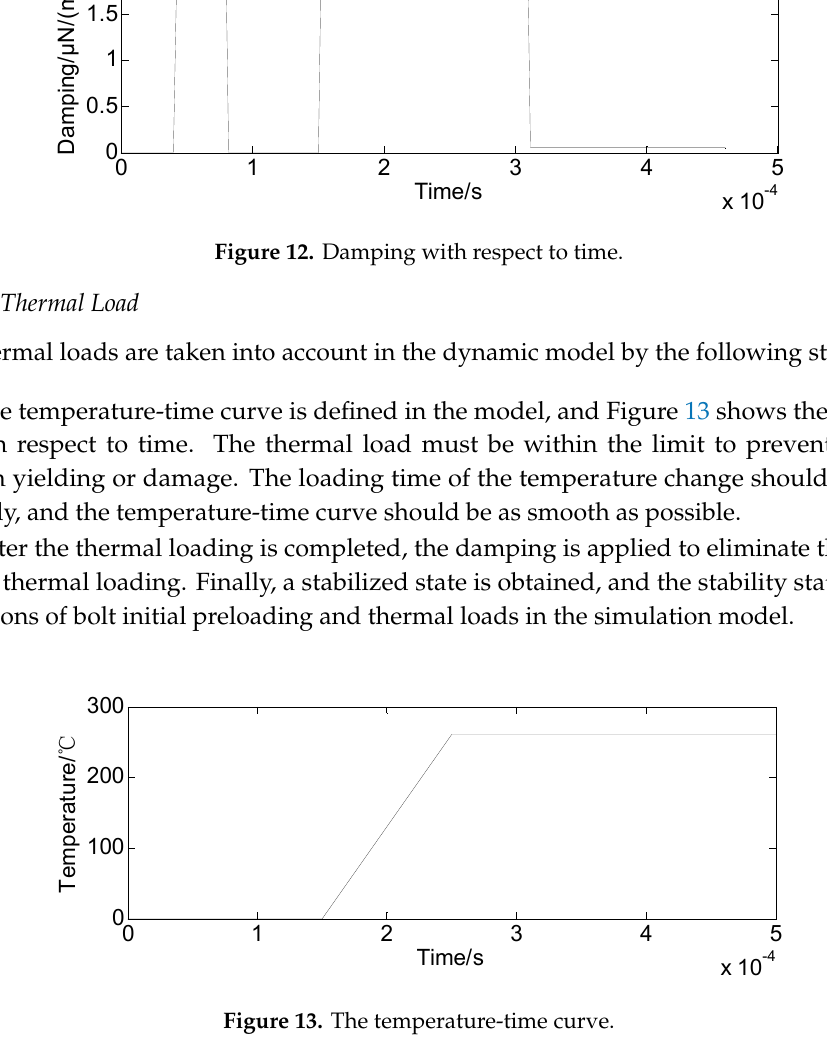
Figure 11. The schematic diagram of nut and mass block with clearance in dynamic analysis.